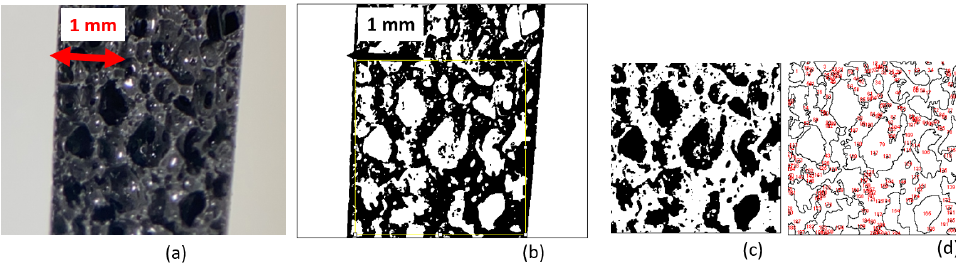
Figure 2. Sample cross-section ( a ), threshold processed picture ( b ), picture analysis selection (yellow square), color inversion of the selected area ( c ), and the result of the picture analysis with the number tag corresponding to the black area on the picture ( d ).